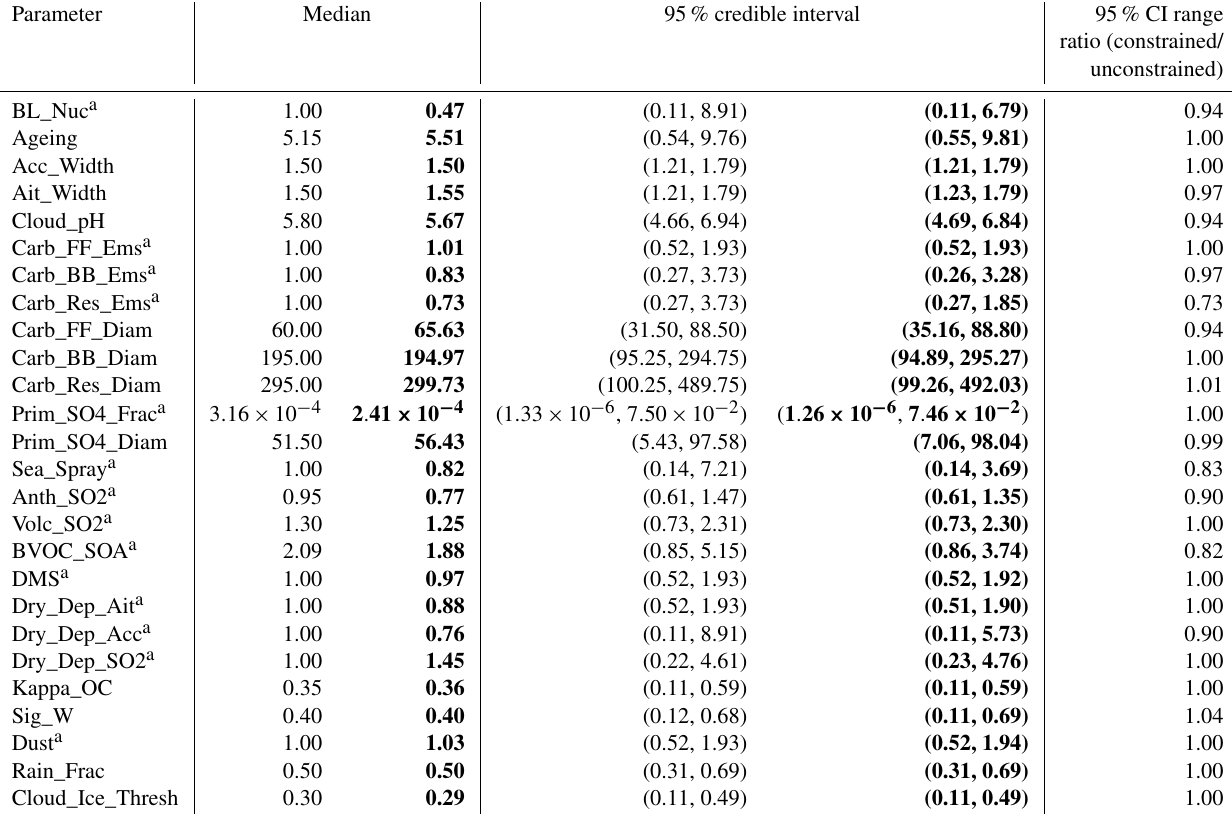
Table 2. Marginal parameter distribution statistics (median and 95% credible interval) for the unconstrained sample of 1 million model variants in normal font and the constrained sample of model variants from the constraint using all measurement types simultaneously in bold. The final column shows the ratio of the constrained to the unconstrained 95% credible interval range, accounting for the nature of the parameter (absolute or multiplicative) by using the log 10 scale for the calculation when the parameter is a multiplicative scaling. Parameter Median 95% credible interval 95% CI range